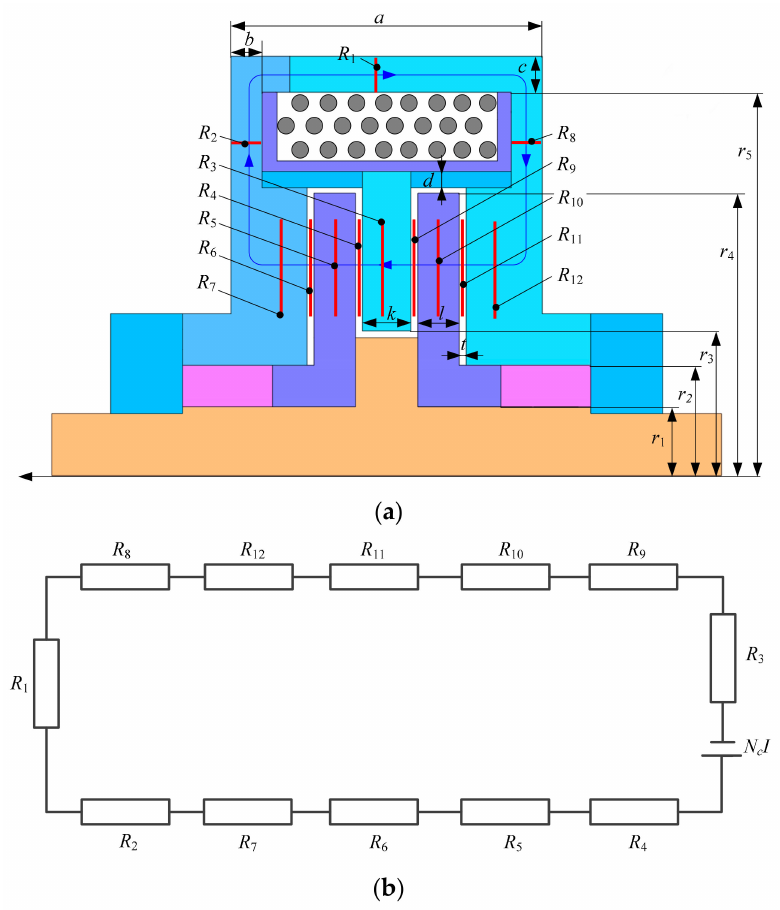
Figure 2. Diagram of magnetic circuit. ( a ) Control sections and ( b ) equivalent